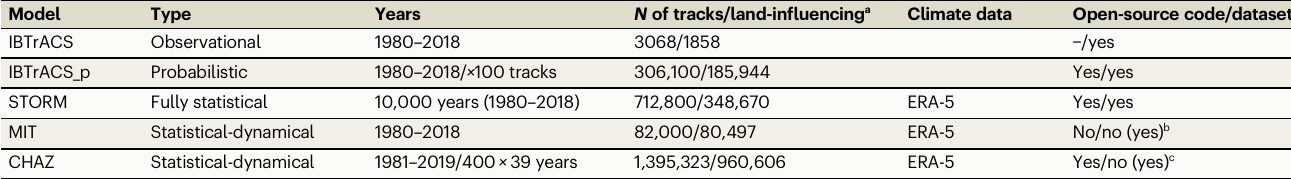
Table 1 | Key qualitative tropical cyclone track set characteristics